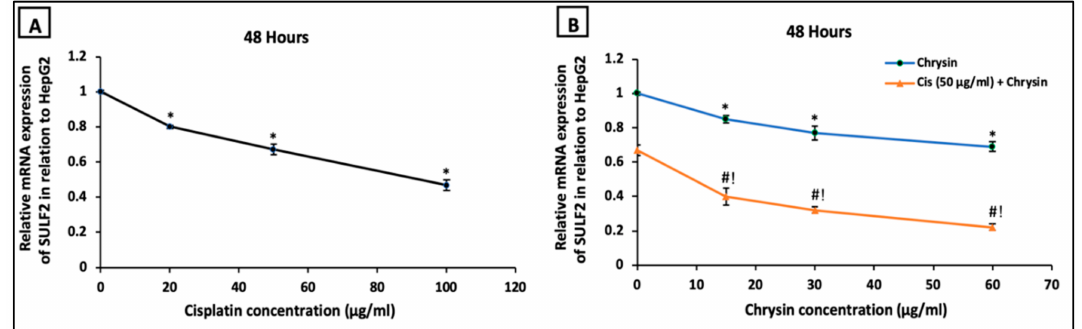
Figure 6. Impact of 48 h treatment with ( A ) cisplatin (Cis; 20, 50, 100 µ g / mL), ( B ) chrysin (15, 30, 60 µ g / mL) and combination of chrysin (15, 30, 60 µ g / mL) with Cis 50 µ g / mL on sulfatase-2 (SULF2) mRNA expressions of in HepG2 cells. Results are presented as Mean ± SD. * p < 0.05 versus the control untreated cells. # p < 0.05 versus the same dose of chrysin. ! p < 0.05 versus Cis 50 µ g / mL.